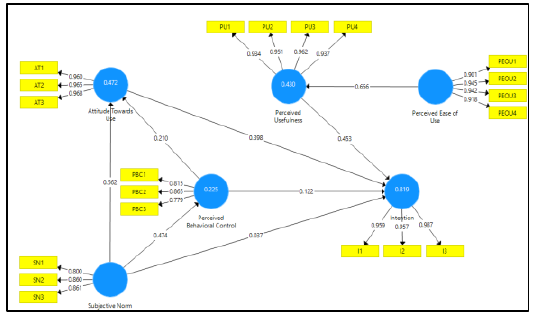
Figure 4. Results of Research Model (Smart PLS) Source: Smart PLS 3